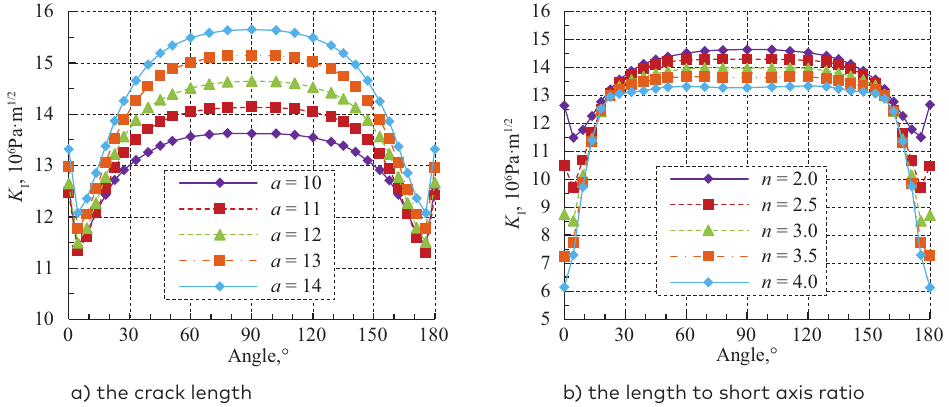
Figure 8. The relationship between stress intensity factor and crack parameters